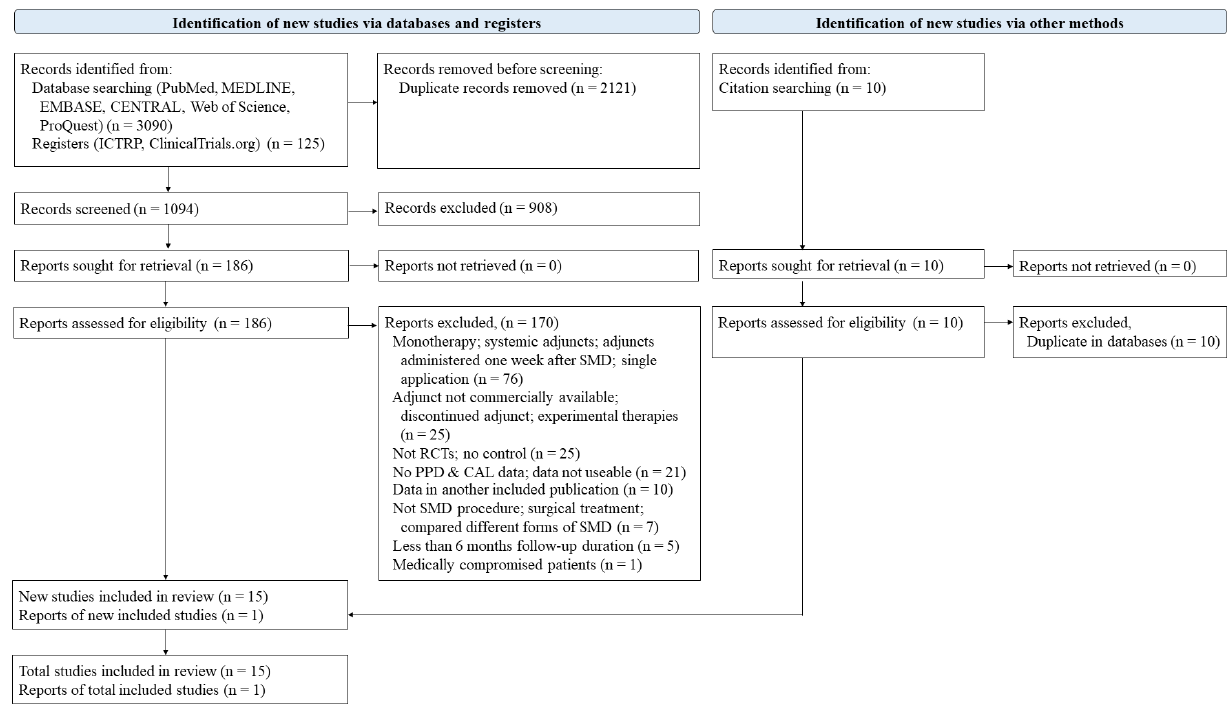
Figure 1. PRISMA flow diagram of the study selection process. Table 1. Study characteristics of the included studies based on